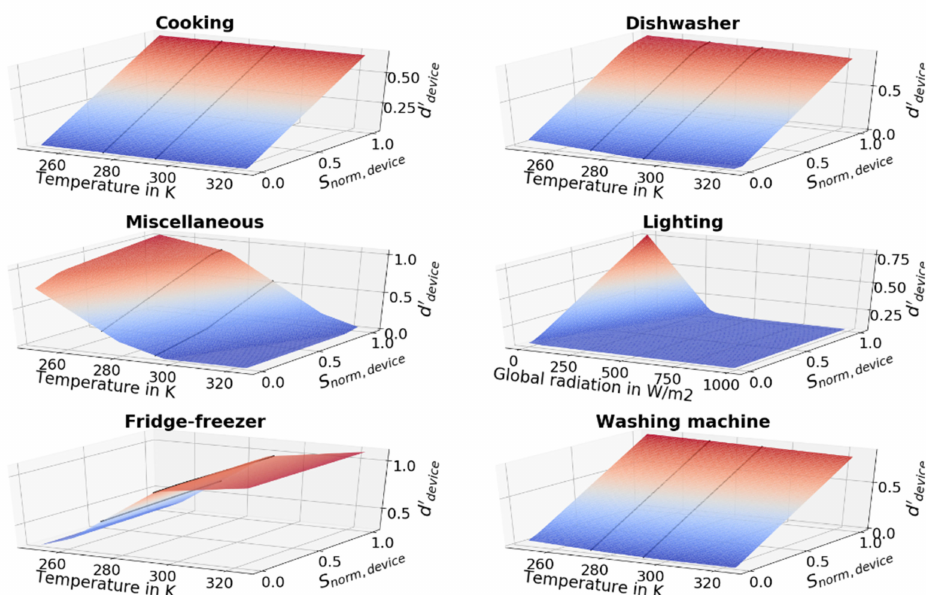
Figure 1. Output of the trained neural networks d device showing the dependence of the total profile d hh,device on the weather data and Stokes’ daily device profile S hh,device . The training range is shown as dotted black